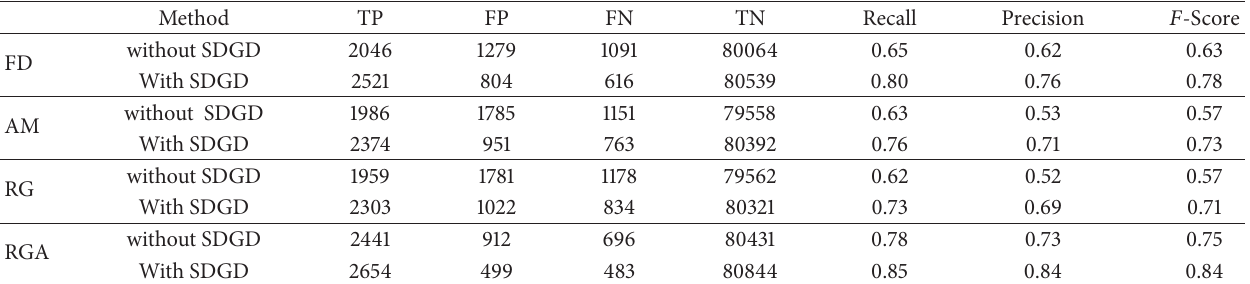
Table 1: Performance for frame 10 in outdoor sample with and without SDGD filter.